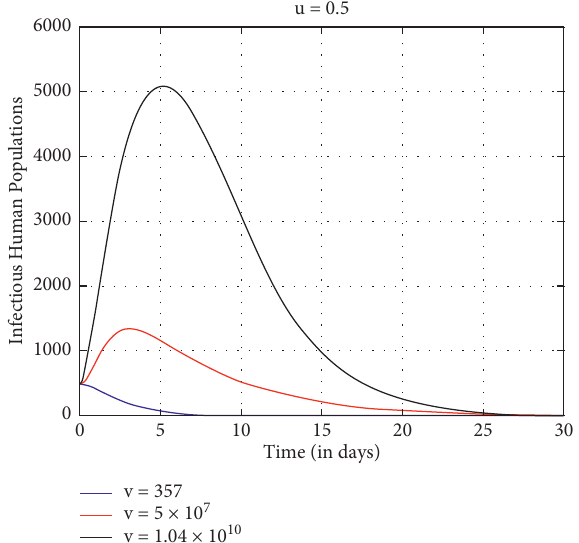
Figure 22: Infectious human population with different virus loads when u � 0 . 5.